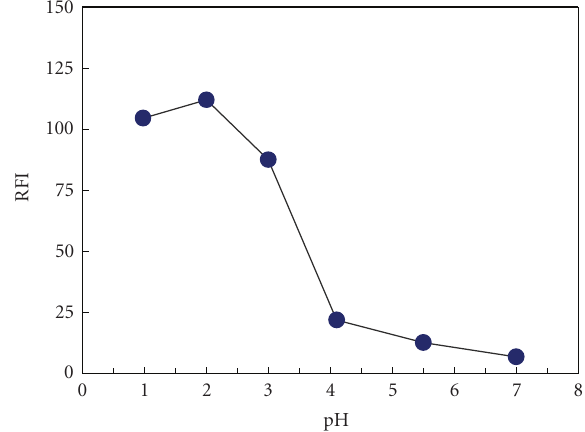
Figure 5: E ff ect of pH on the fluorescence intensity of the reduced reaction product of AMD-NQS. RFI is the relative fluorescence